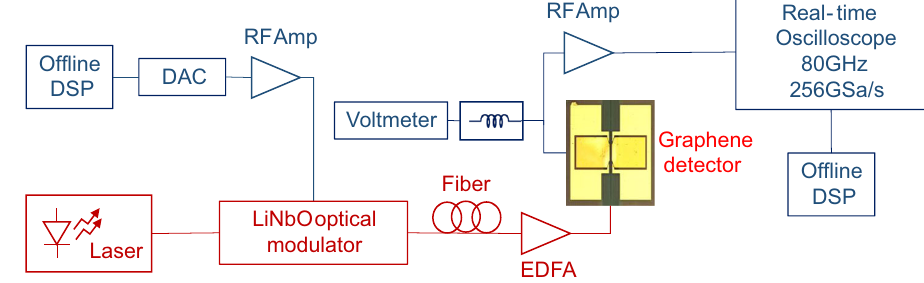
Fig. 5 Experimental setup. High speed optical testbed with a DAC based transmitter and an ADC based receiver.